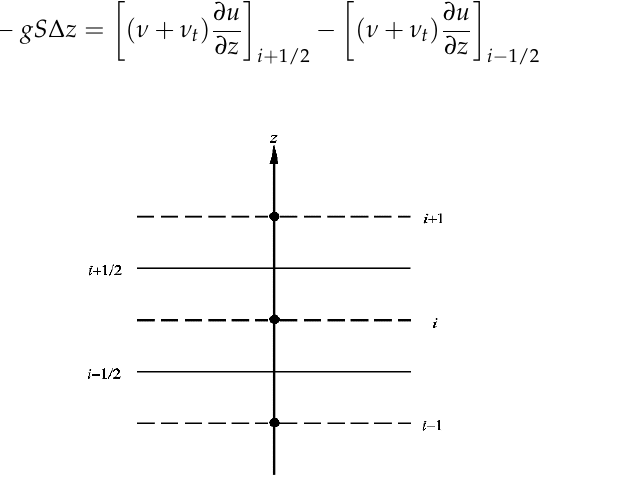
Figure 3. Grid discretization ( i = 2, 3, …, N − 1) .